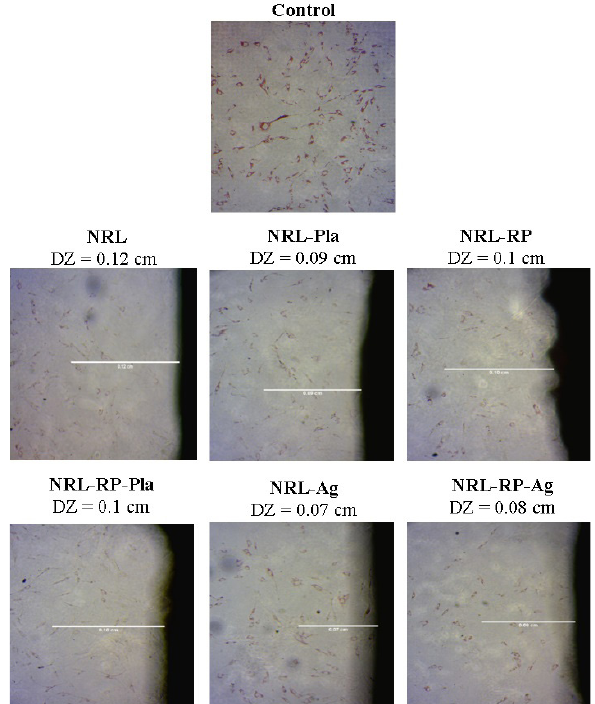
Figure 7. Overlay assay with ADSCs. Visualization on inverted microscope (magnification of 40 ×). Measurements of discoloration zones (DZ) carried out on ImageJ, with scale calibration (0.1